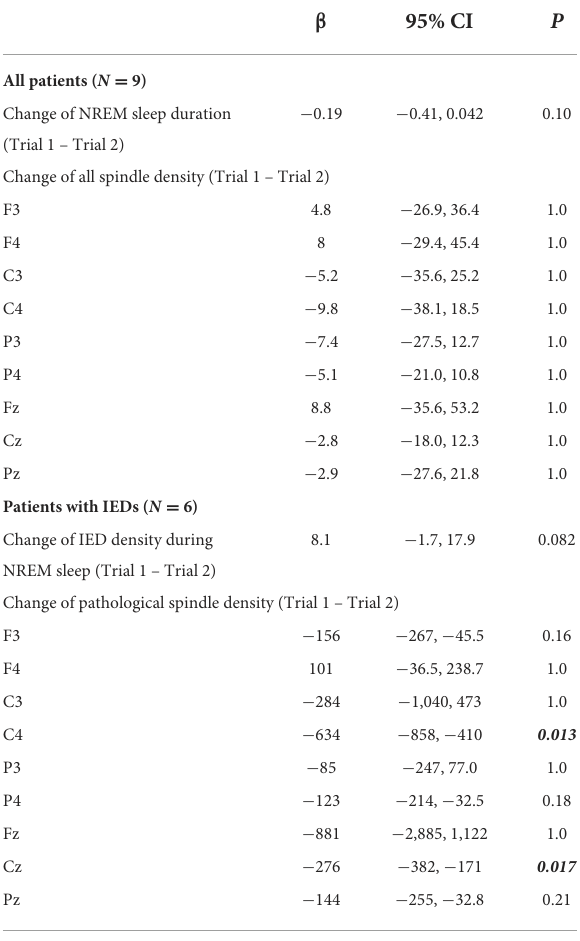
TABLE 1 Regression analysis with change in sleep-dependent learning effect (Trial 1 – Trial 2). β 95% CI